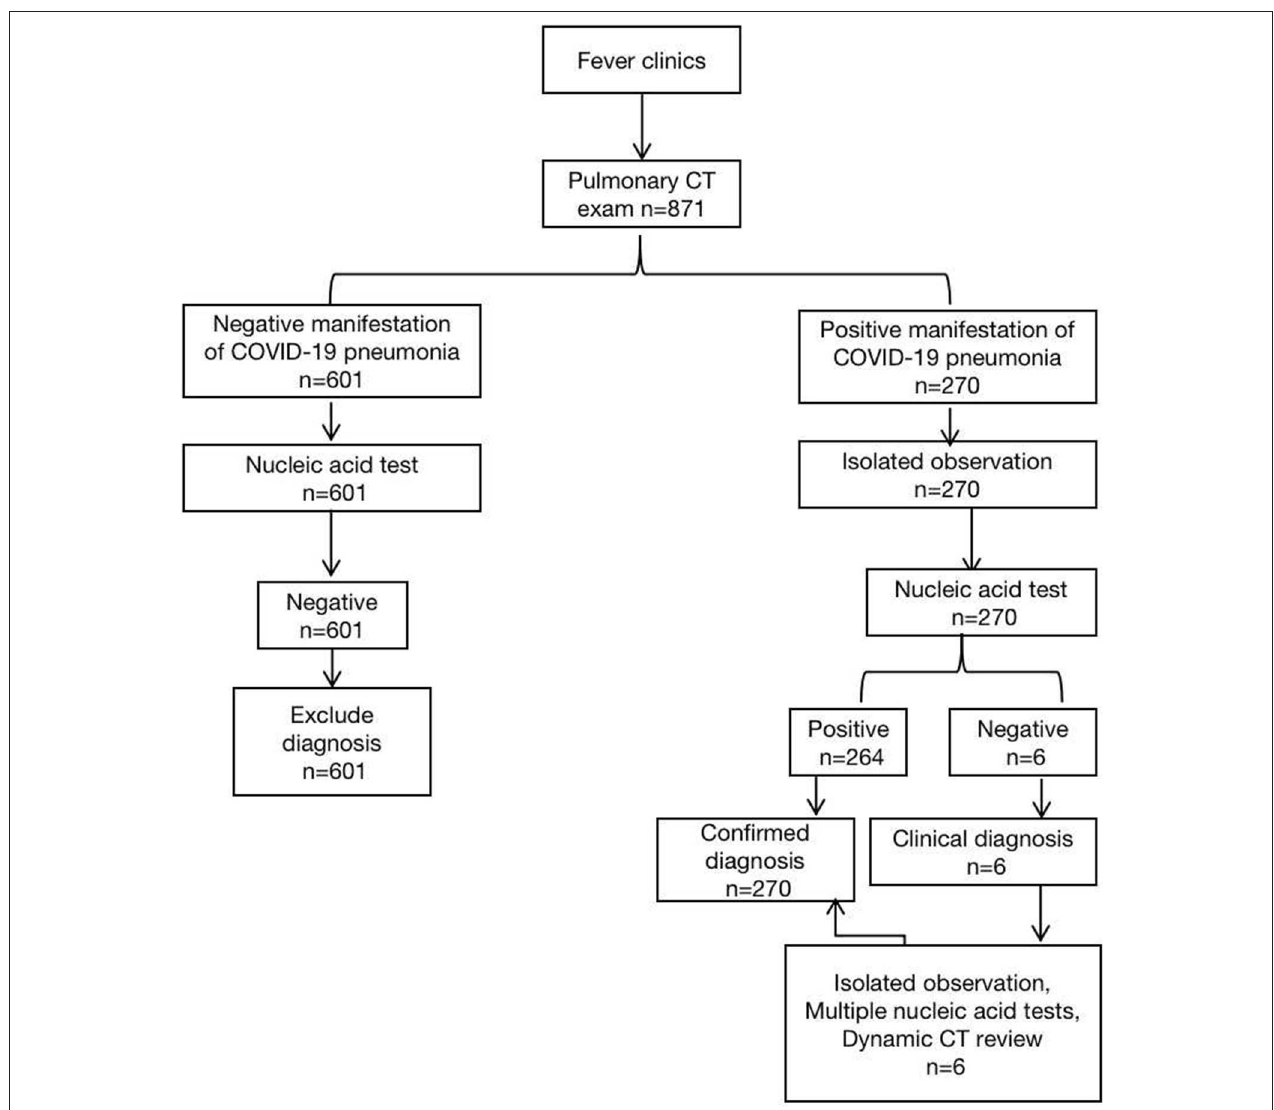
FIGURE 1 | Flow chart of CT examination of fever clinics in Hubei Province.